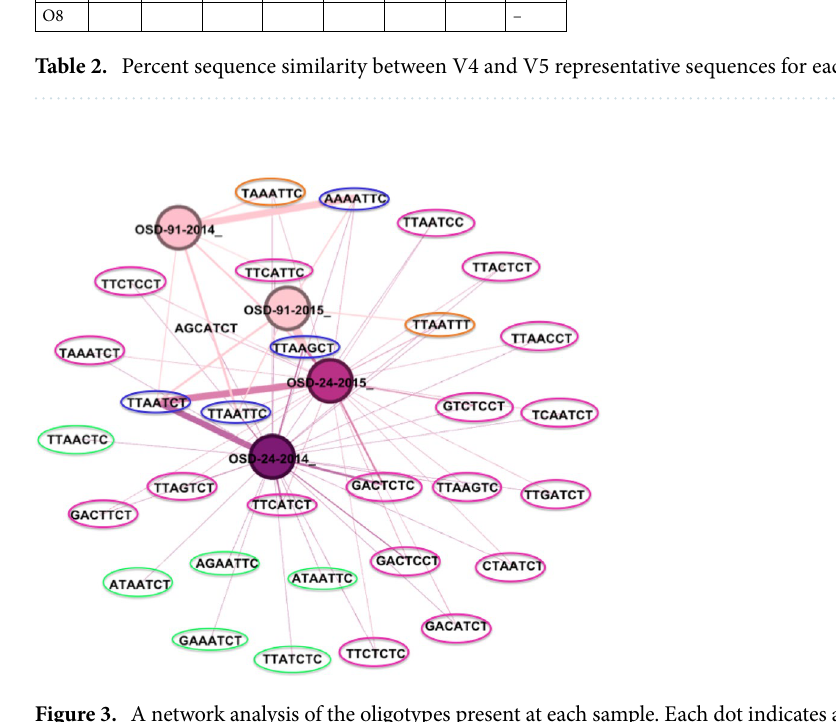
Figure 3. A network analysis of the oligotypes present at each sample. Each dot indicates an oligotype present in at least one sample, and each edge on the network connects an oligotype to one or more samples. Colored circles represent oligotypes present in only one, two, three, or all